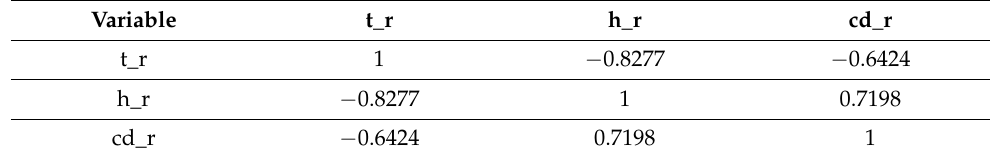
Table 6. Correlation coefficient of the residual component environmental variables of the rabbit house.